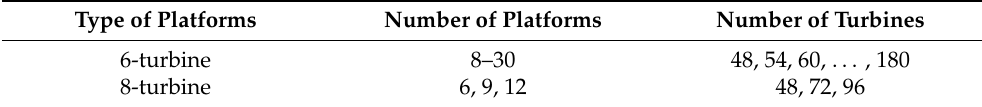
Table 2. Summary of analytical cases.